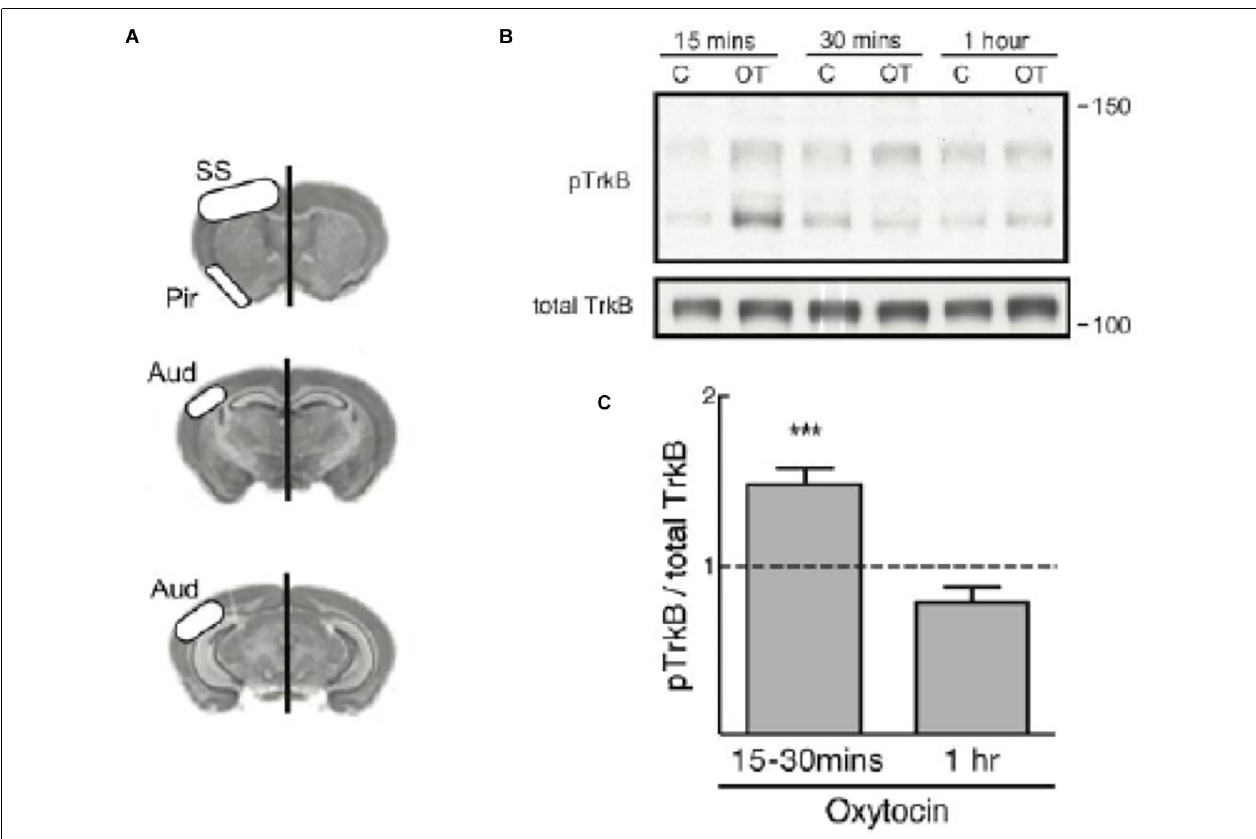
FIGURE 2 | TrkB phosphorylation is elevated in mouse cortical slices treated with oxytocin. (A) Diagram regions of the slice dissection. (B) A representative immunoblot for TrkB phosphorylation (pTrkB from Chao lab) from brain slices treated with oxytocin (OT) at 1 µ M for different time course (upper band is size of full length TrkB). Total TrkB, R & D AF1494. (C) The graph demonstrates pTrkB levels in mouse cortical tissue slices ( n = 12). Summary plot of quantitative analyses of densitometric immunoblot scans from 12 independent experiments with oxytocin treatments at 15–30 min or 1 h. pTrkB/total TrkB ratio is reported and was calculated by taking the ratio of the pTrkB densitometric signal over the total TrkB densitometric signal for each sample, and then represented as a value relative to untreated control (oxytocin 15–30 min: 1.39 ± 0.08, N = 12, *** p < 0.0001; oxytocin 1 h: 0.69 ± 0.04, N = 3, p > 0.06). The p value was determined with ANOVA test followed by post-hoc Tukey (*** p <